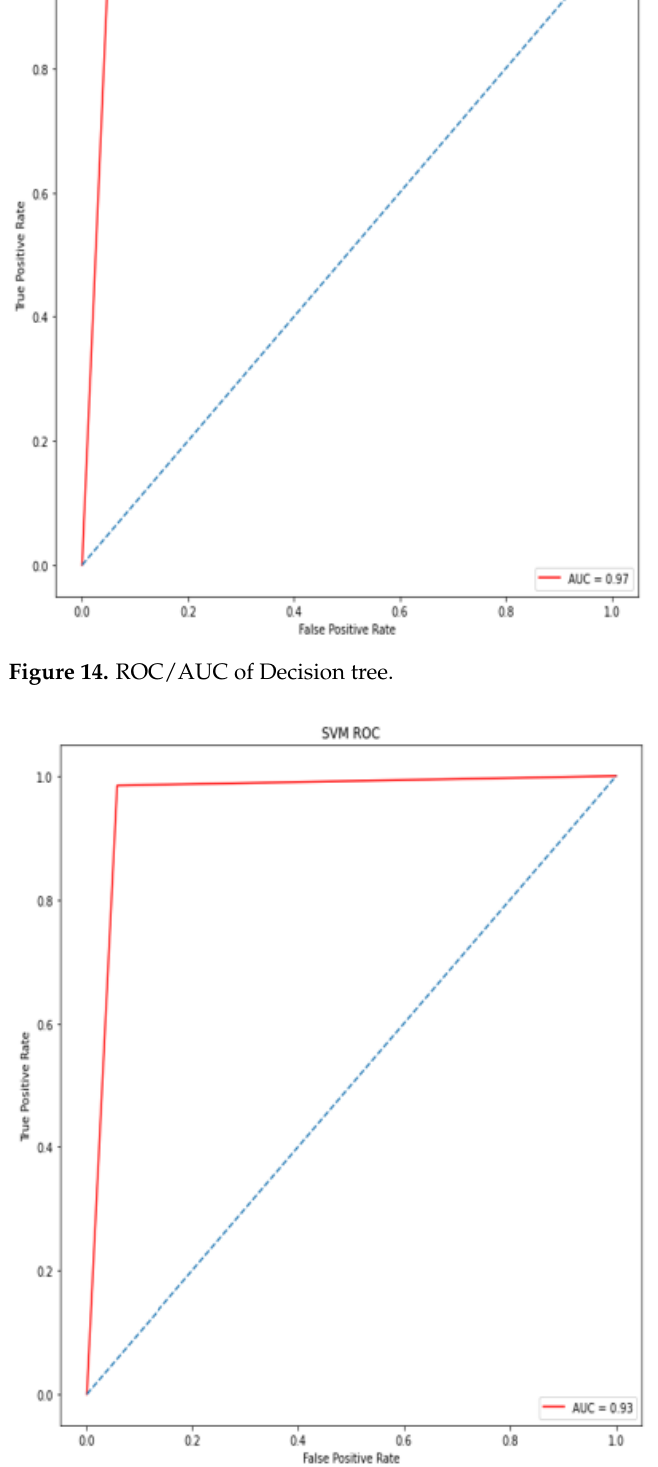
Figure 15. ROC/AUC of SVM.